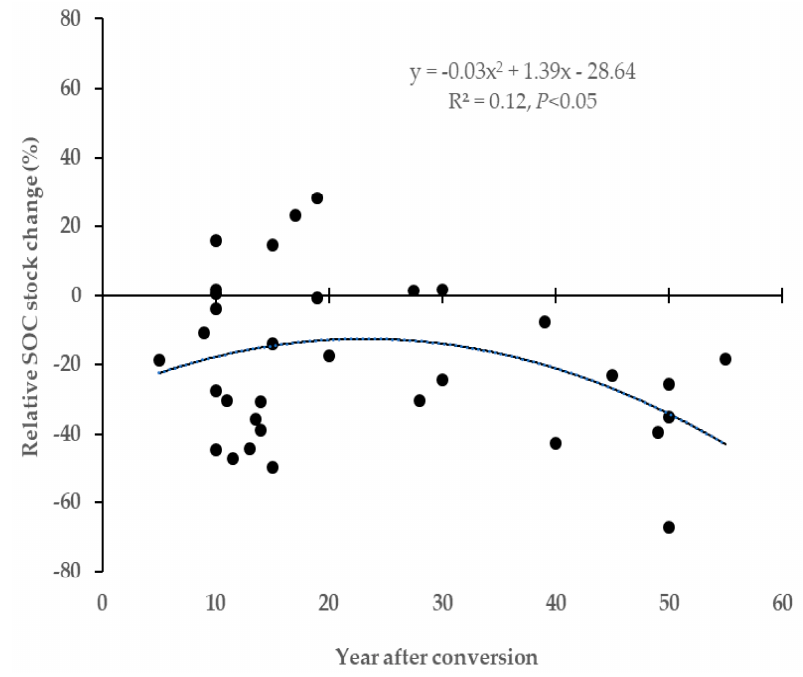
Figure 4. Relative SOC stock change over years after conversion from primary forest to rubber plantation (data source: Tables S1–S4) in tropical mineral soils. One high value (151%; almost 4 times the nearest value) was excluded from the dataset.